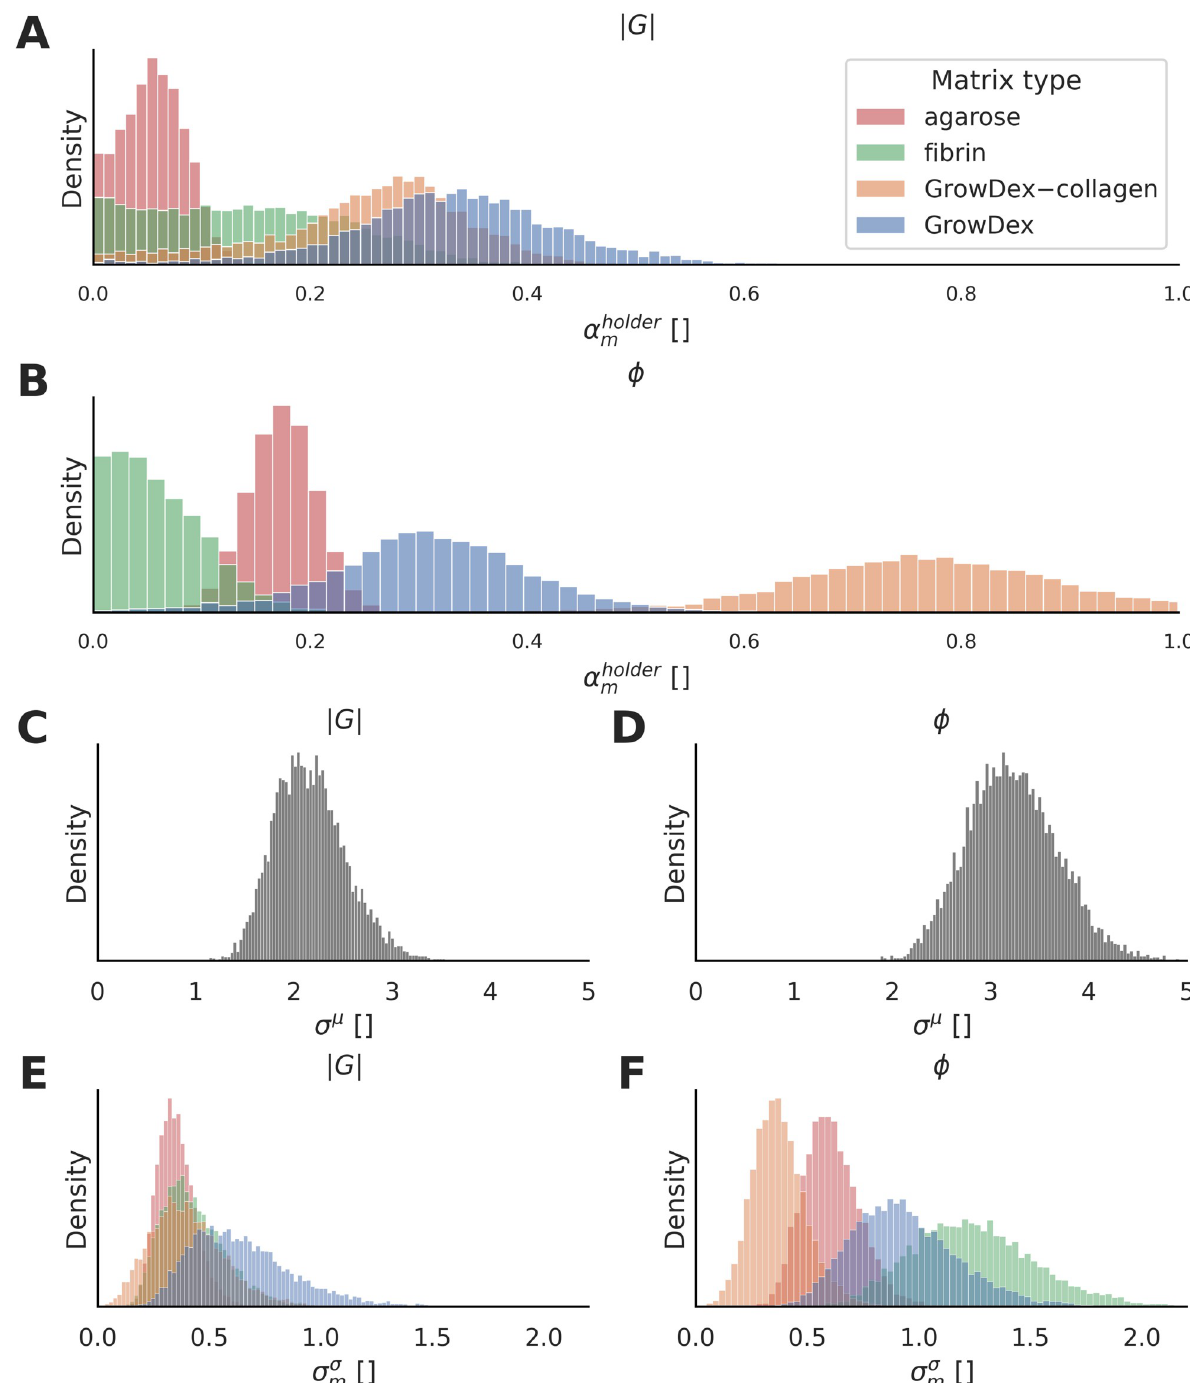
Fig 4. Multilevel Bayesian model enables distinguishing of the heterogeneity in matrix viscoelasticity from the effects of experimental design and measurement errors. A–B : Posterior distributions of absolute shear modulus (| G |) and phase angle ( ϕ ). For each matrix type, the distribution peak describes the mean of the heterogeneity estimate, while the distribution width indicates uncertainty. C–D : Estimated average measurement errors are shown for | G | and ϕ . E–F : Estimated error’s variability between individual magnetic spheres are shown for | G | and ϕ . The distribution peak describes the magnitude of the estimated error’s variability in each matrix type. For all plots, the X axes show the | G | data or the ϕ data that are z-score normalized (unitless), and the Y axes represent the probability density of the distributions (unitless).